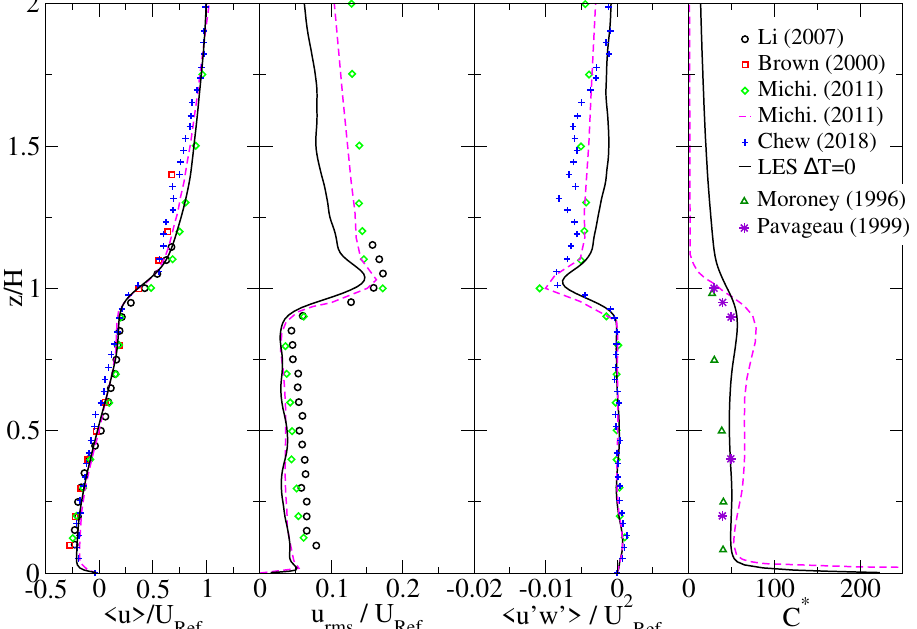
Figure 2. Non-dimensional mean streamwise velocity u , its root-mean square u rms , the turbulent kinematic momentum flux u (cid:48) w (cid:48) and the concentration C ∗ . Quantities are plotted along the canyon centre line x / H = 1. Lines are numerical simulations: black solid line, present LES of neutral case ( ∆ T = 0); pink dashed line, LES by Michioka et al. [47]. Symbols are laboratory measurements: black ◦ , Li et al. [36]; red (cid:3) , Brown et al. [53]; light green (cid:5) , experiment Michioka et al. [47]; blue + , Chew et al. [48]; dark green (cid:52) , Meroney et al. [56]; violet ∗ , Pavageau and Schatzmann